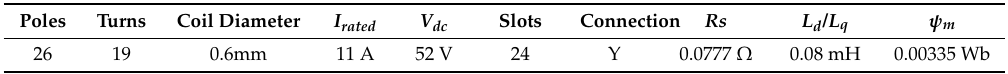
Figure 7. SPMSM design. Table 1. Motor parameters at 20 °C.